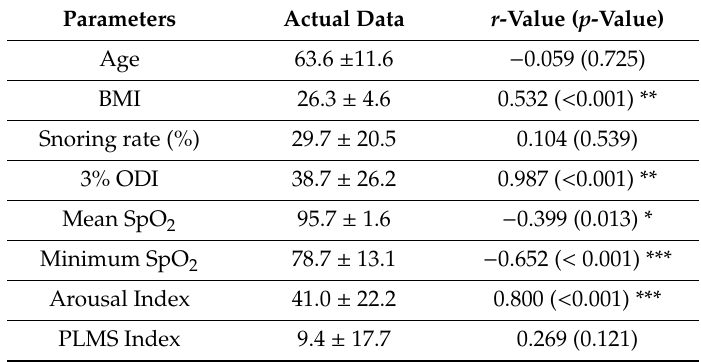
Table 2. Correlation matrix between various parameters and the apnea-hypopnea index (AHI).